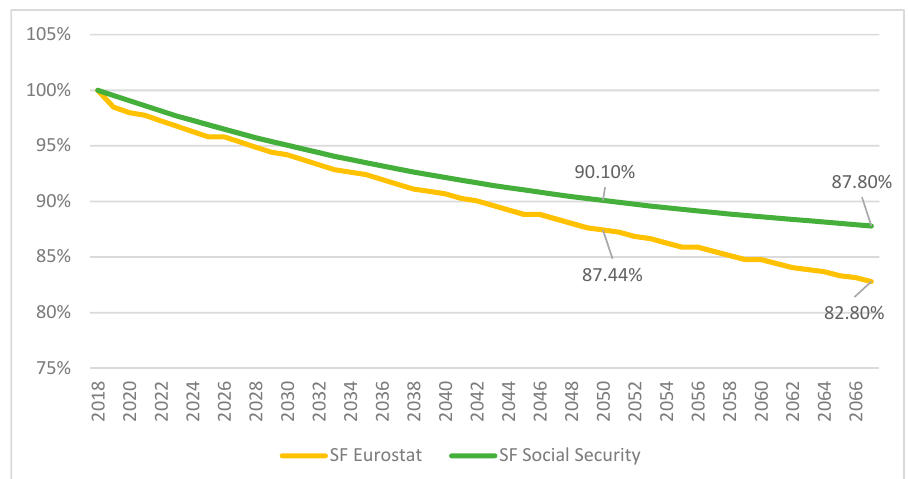
Figure 4. Sustainability factor 2018–2067, Eurostat and Social Security tables.